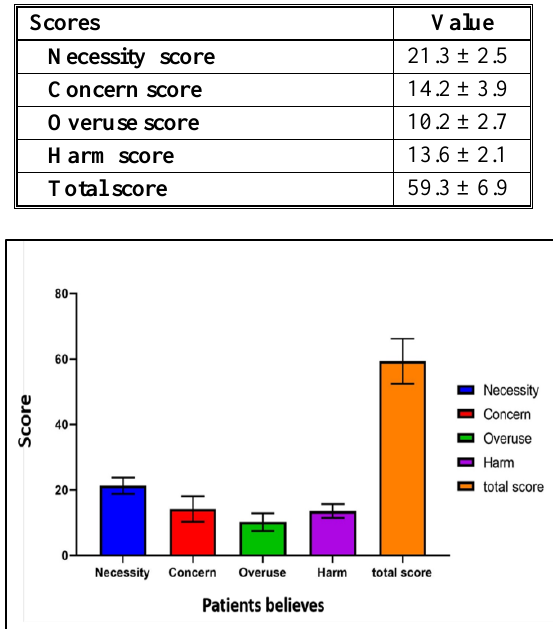
Figure 2. Beliefs about medicines questionnaire scores of